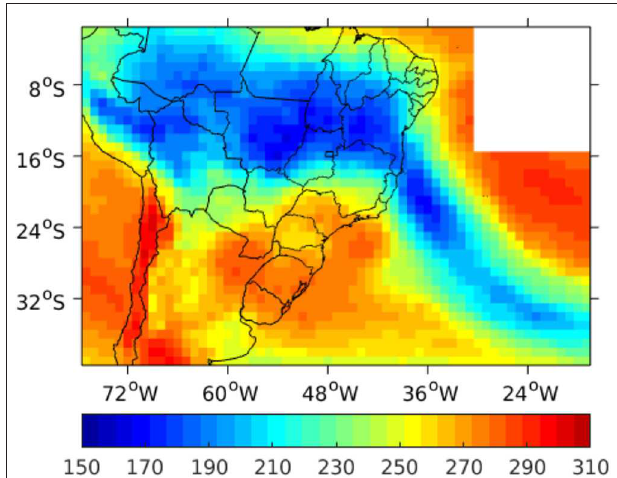
FIGURE 1 | Spatial domain used in the classification algorithm. The upper right corner was removed to avoid the ITCZ convection influence. Mean OLR (W m − 2 ) during the observed SACZ episode from 12 to 18 January,